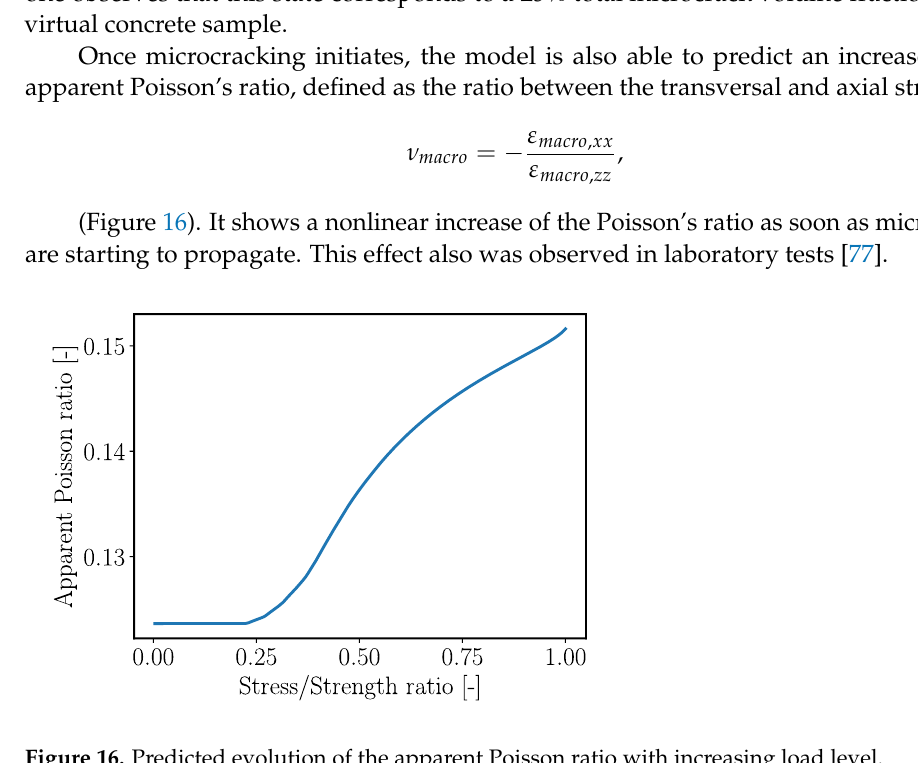
Figure 16. Predicted evolution of the apparent Poisson ratio with increasing load